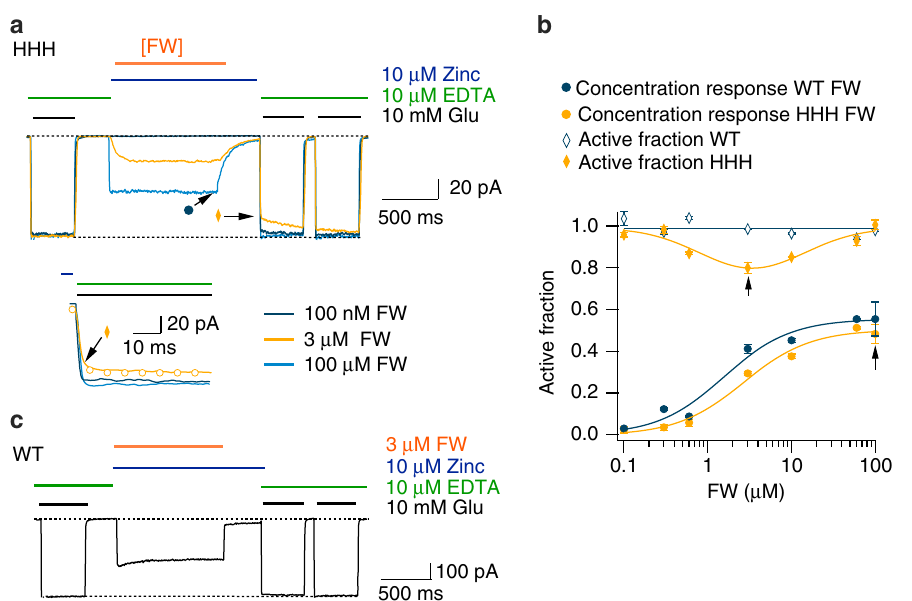
Figure 6 | HHH traps at intermediate concentrations of FW. ( a ) Trapping at different concentrations of FW. Three records from different patches showing trapping after the application of Zn 2 þ (10 m M) for 100nM (dark blue), 3 m M (orange) and 100 m M FW (light blue). The inset shows the current after trapping displaying a robust reduction occurring at 3 m M. The fits (dots) are double exponentials fitted to the recovery after trapping the arrows and symbols indicate measurements plotted in c . ( b ) Currents from WT GluA2 were not modified at any concentration of FW. ( c ) Dose–response curves for FW in Zn 2 þ and 100 m M CTZ for WT GluA2 ( EC 50 ¼ 1.7 ± 0.2 m M) (closed blue circles) and the mutant HHH (closed yellow circles) ( EC 50 ¼ 2.7 ± 0.3 m M). The active fraction for WT GluA2 is flat (blue open dots). The active fraction for the HHH mutant (open yellow circles) is fit by a log-normal function with a maximum inhibition at 3 m M FW. All error bars are s.e.m. ( n ¼